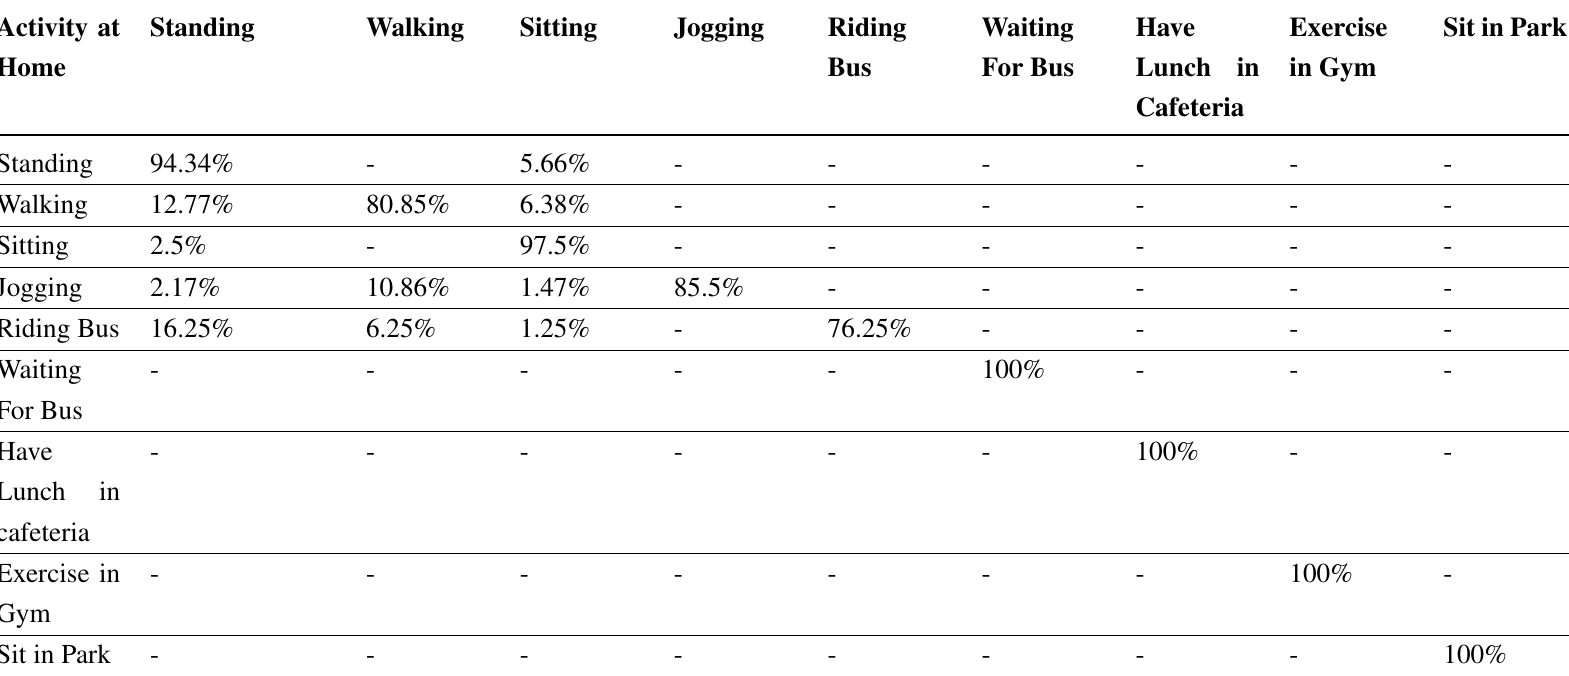
Table 4. Activity Recognition Accuracy for